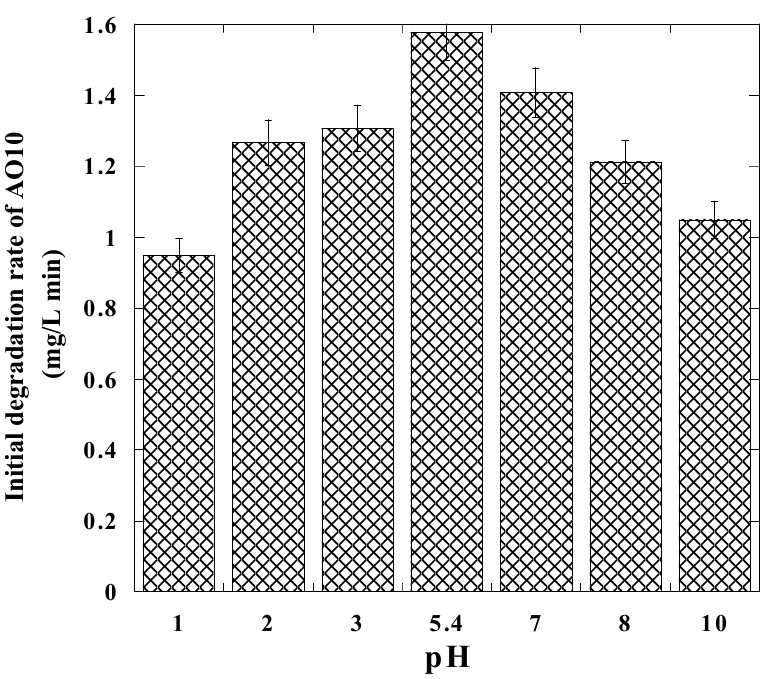
Figure 6. Effect of the initial pH on the AO10 degradation rate ([AO10] 0 = 50 mg/L, 20 ± 1 °C, [IO 4 − ] = 3 mM, irradiation intensity: 15 mW/cm²).